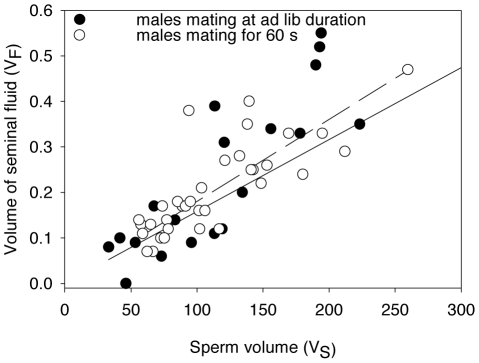
Relationship between interrupted and non-interrupted matings in the common bedbug Cimex lectularius.Correlation between the volume of sperm VS and seminal fluid VF stored by males after mating ad libitum and after mating for 60 s (the standard duration used in this paper, SM). The fact that SM did not have a smaller slope than ad libitum matings shows that SM did not result in truncation of seminal fluids.